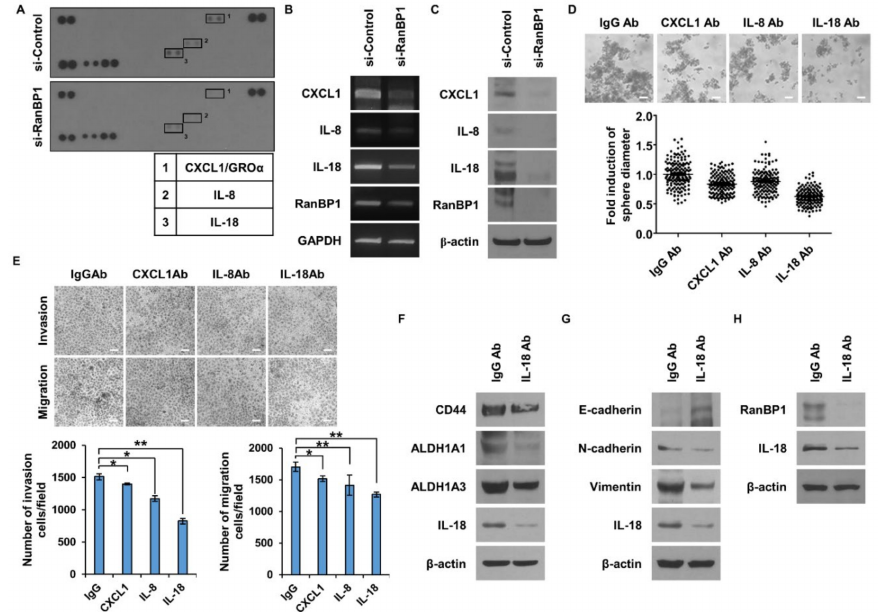
Figure 4. Cytokines regulated by RanBP1 in lung cancer. ( A ) Identification of secreted factors regulated by RanBP1 using cytokine arrays. A549 cells are used, and the expression of RanBP1 is suppressed using si-RNA. ( B ) Comparison of the gene expression of cytokines regulated by RanBP1. ( C ) Analysis of cytokines regulated by RanBP1 using WB. ( D ) Comparison of the sphere formation ability after each neutralizing antibody treatment. The p value is less than 0.0001 versus the IgG Ab value. ( E ) Comparison of migration and invasion ability of cells after each neutralizing antibody treatment. Experiments performed in triplicate. ( F ) CSC marker protein analysis in A549 after treatment with IL-18 neutralizing antibody. ( G ) Confirmation of the expression levels of EMT marker proteins after treatment with the IL-18 neutralizing antibody. ( H ) Expression analysis of RanBP1 regulated by IL-18 using neutralizing antibodies. Error bars represent mean ± SD. Triplicate samples. * p < 0.05, ** p < 0.001, versus control. Scale bar = 50 µ